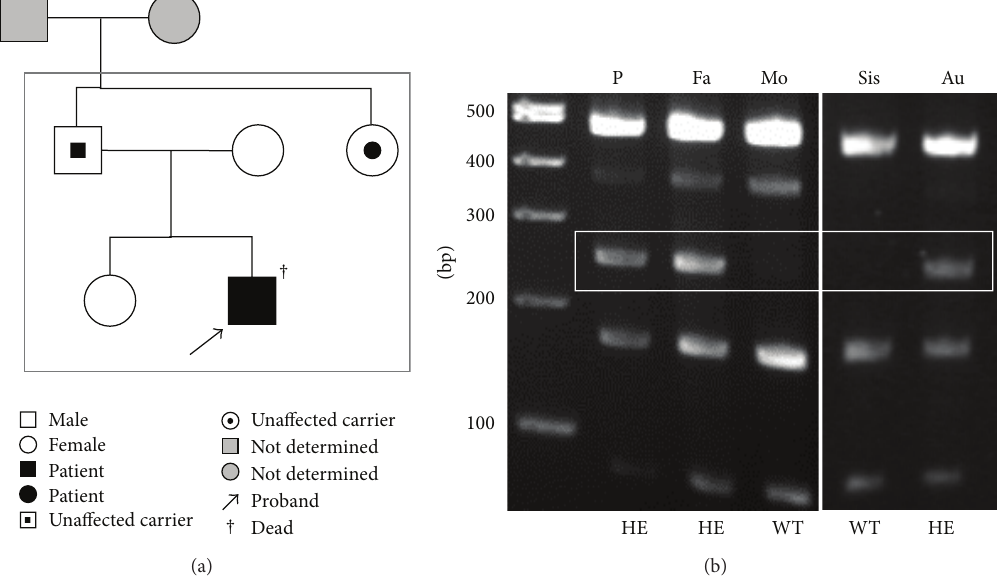
Figure 2: (a) The pedigree of the patient. (b) RFLP analysis. P: proband, Fa: father, Mo: mother, Sis: sister, Au: aunt, WT: wild type, and HE: